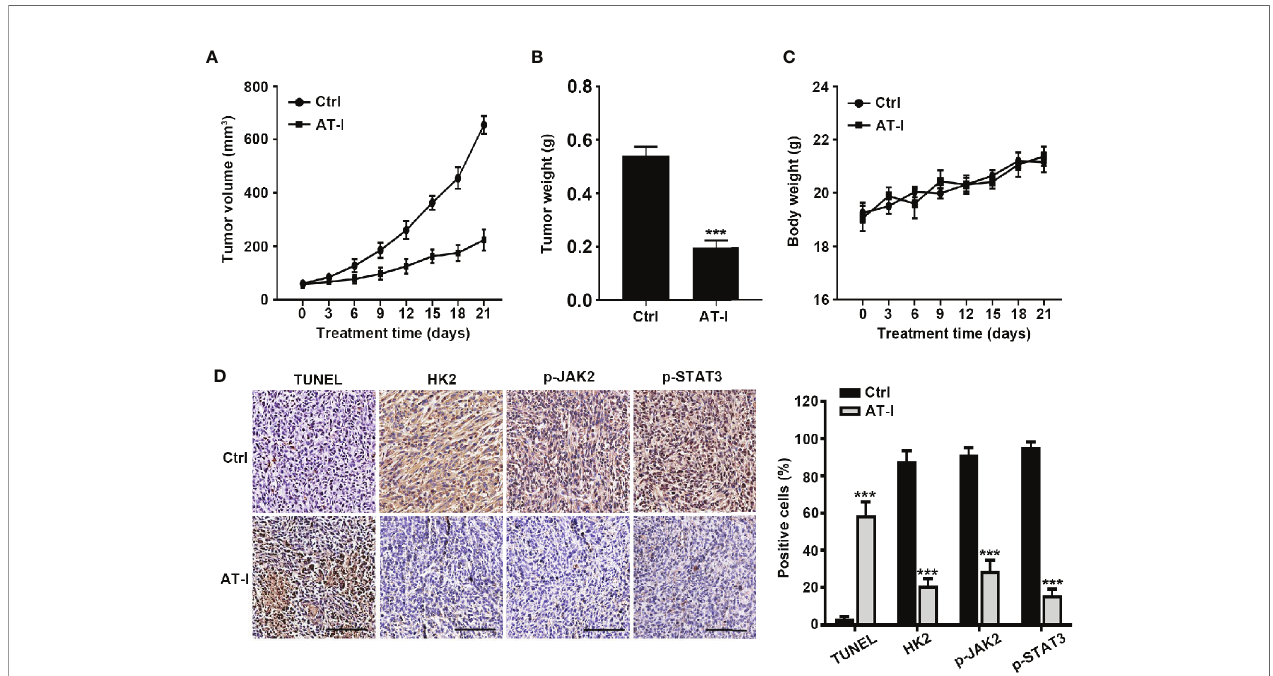
FIGURE 7 | AT-I inhibits the growth of CRC cells in a nude mice xenograft Assay. Mice were administrated with vehicle or AT-I at 50 mg/kg/day for 3 weeks. Tumor volumes (A) , tumor weight (B) and body weight (C) of mice were measured. (D) Histological analysis of TUNEL, HK2, p-JAK2 and p-STAT3 levels in tumor tissue sections. Left: representative images of immunohistochemical analysis of tumor sections. Scale bar = 100 m m. Right: quanti fi cation of the percentage of positive cells in tumors. Data are represented as mean ± SD. *** p < 0.001 versus the Ctrl